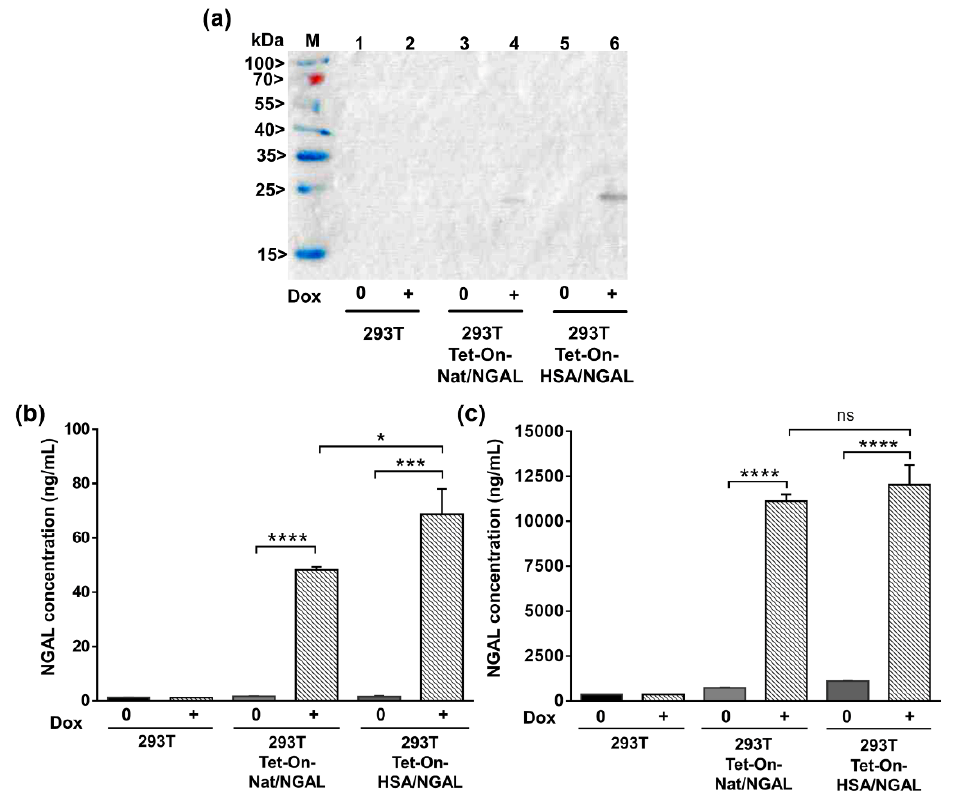
Figure 4. The expression of the NGAL protein in culture supernatants and cellular lysates. ( a ) Detection of NGAL in culture supernatant by Western blot analysis using anti-His tagged monoclonal antibody. Lane 1 and 2 showed 293T control cells with and without Dox. Lane 3 and 4 showed 293T Tet-On-Nat/NGAL with and without Dox. Lane 5 and 6 showed 293T Tet-On-HSA/NGAL with and without Dox, respectively. ( b ) The concentrations of secreted NGAL in the culture supernatant and ( c ) the level of cellular NGAL were measured by ELISA. The results were obtained from triplicate experiments (mean ± SD). Data were analyzed using Student’s t -test (* p < 0.05, *** p < 0.001, **** p < 0.0001).